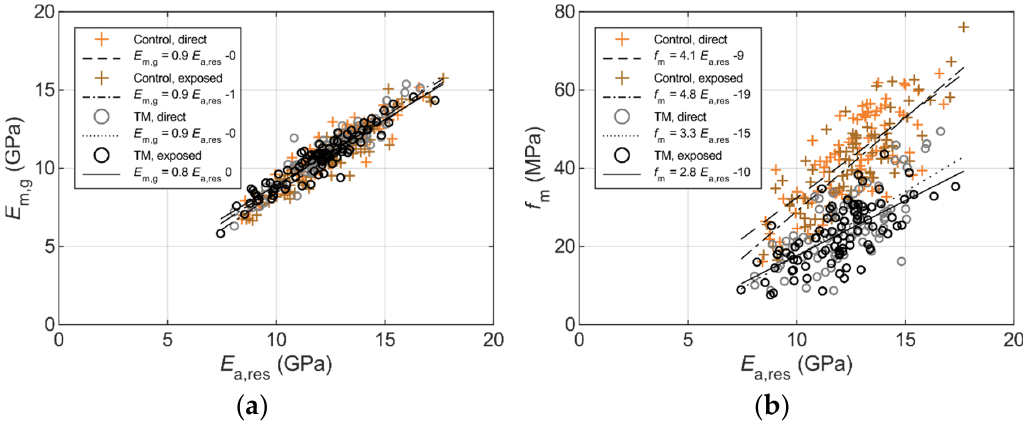
Figure 12. Relationships between static bending properties and dynamic elastic modulus of